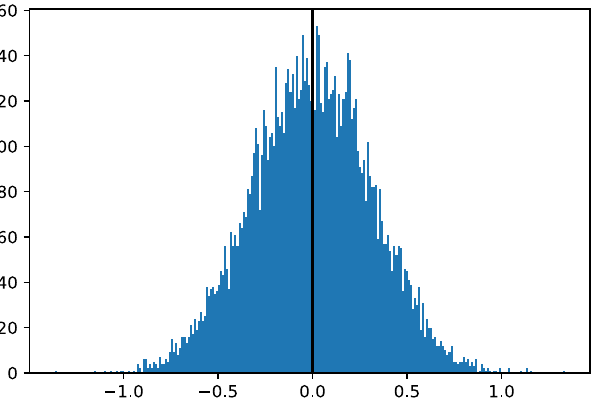
i N ( 0, 10 ) , ε i N ( 0, 1 ) , and t ∼ t ∼